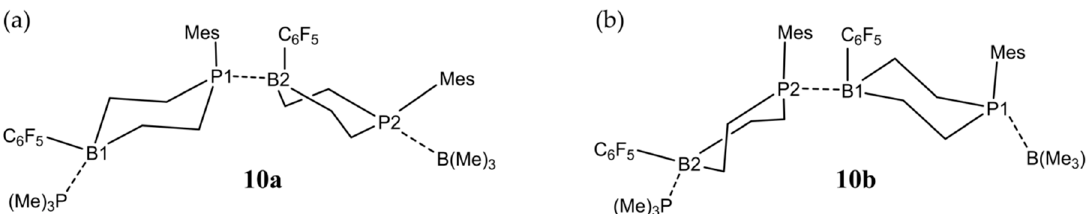
Figure 32. Chair- and boat-like conformational geometries present in 9 . To facilitate the DFT calculation of the NMR observables, the simplified molecules 10a and 10b shown served as models for the cutouts of the molecular structure of 9 , where, for instance, NMR parameters of P1 and B2 were calculated using 10a .